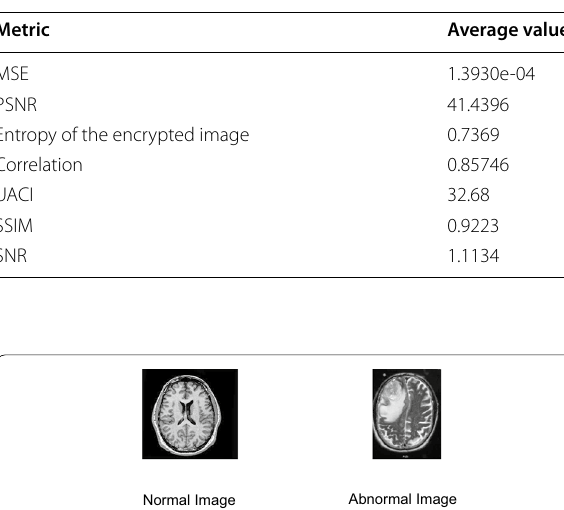
Table 4 Statistical evaluation metrics